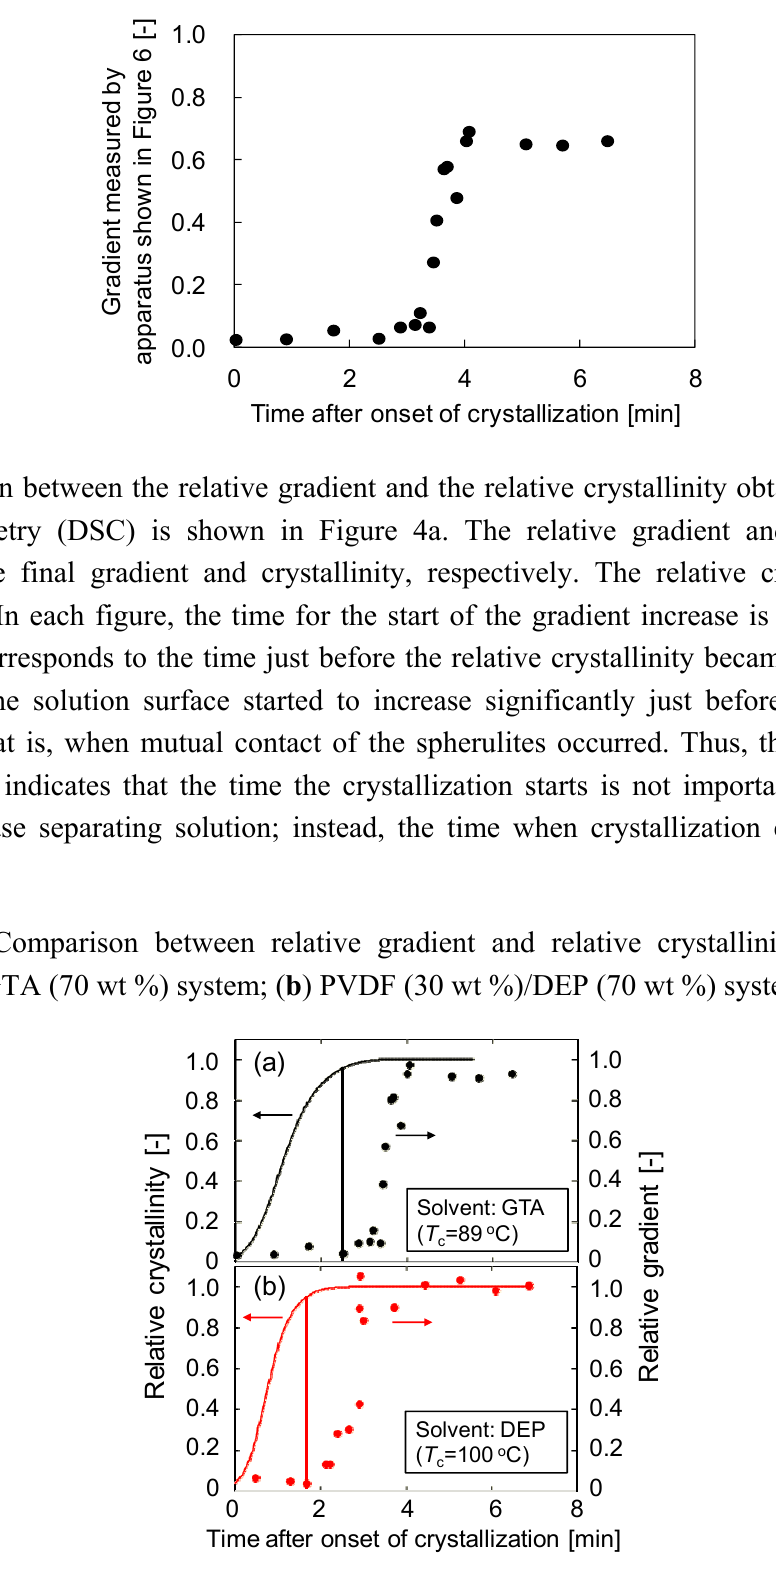
Figure 3. Variation of the ratio of the needle displacement to stage displacement with time after the onset of crystallization in the PVDF (30 wt %)/GTA (70 wt %) system.